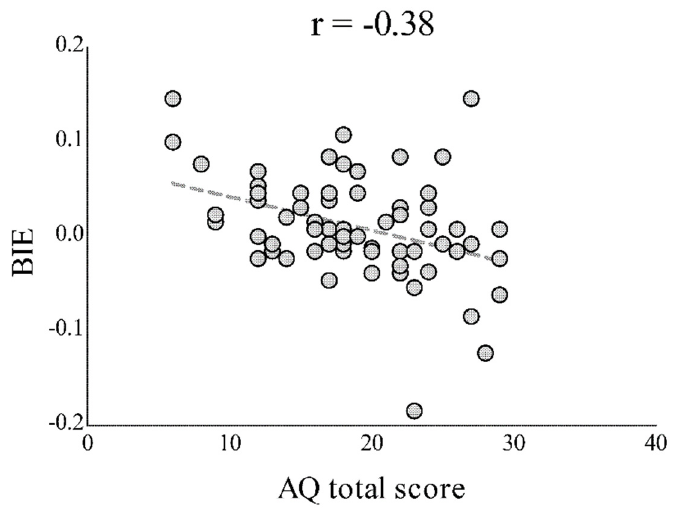
Figure 4. Correlation between the body inversion effect (BIE), calculated as the difference between the accuracy rating for upright body images and the accuracy rating for inverted body images, and the total score for the autistic quotient (AQ). This relationship indicates that the higher the participant’s level of autistic traits, the lower the difference between the posture recognition ability of upright and inverted high-filtered body images.